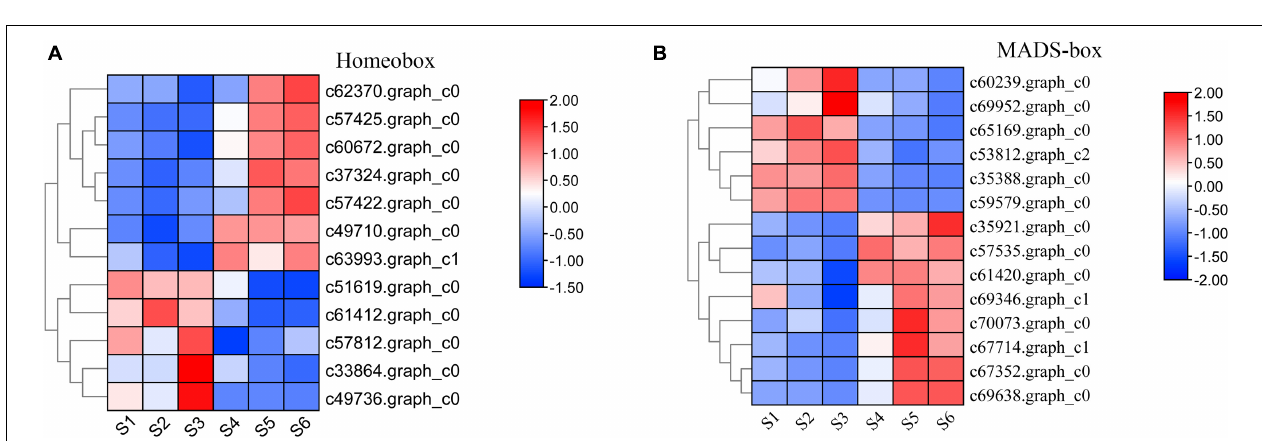
FIGURE 7 | Expression pattern of development-related genes during six growth stages of the C . sinense ovule. Expression patterns of DEUs annotated from the homeobox (A) and MADS-box (B) superfamilies. The color of each box represents log2(FPKM + 1) values, negative values (blue) represent down-regulation and positive values (red) represent up-regulation. Only DEUs from these two superfamilies are